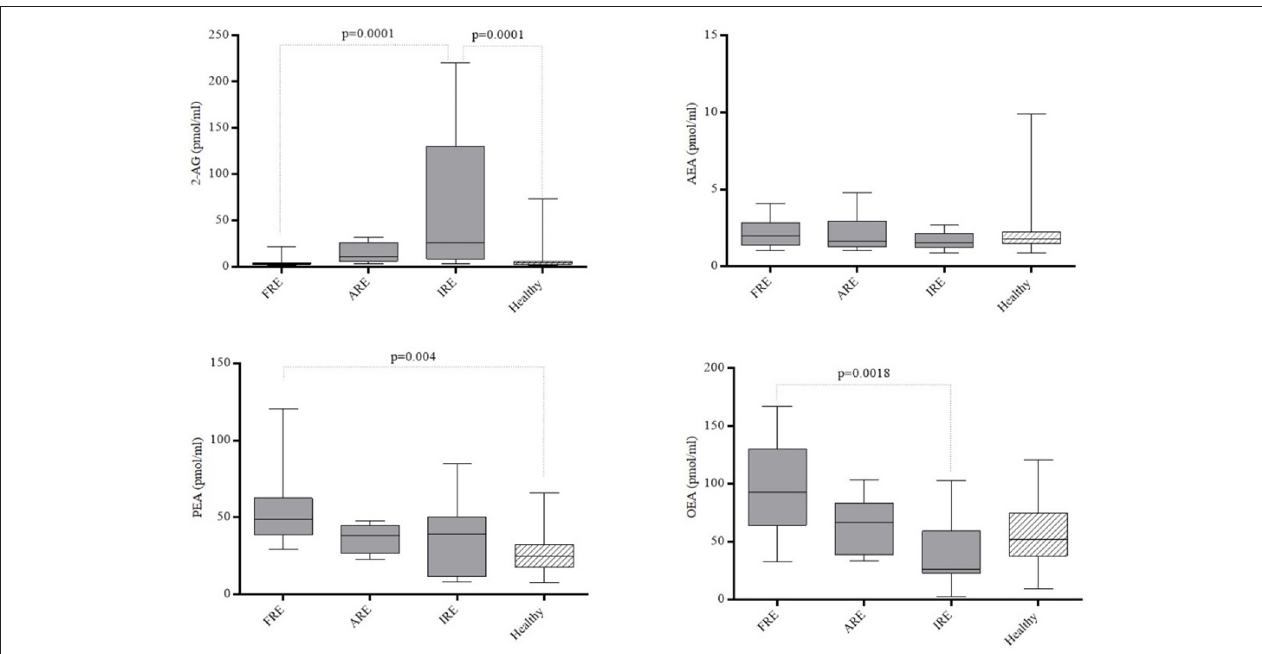
FIGURE 2 | Plasmatic concentrations of 2-arachidonoylglycerol (2-AG), N-arachidonoylethanolamine (AEA), N-palmitoylethanolamine (PEA) and N-oleoylethanolamine (OEA) in healthy dogs and in dogs affected by Food-responsive Enteropathy (FRE, n = 10), Antibiotic-responsive Enteropathy (ARE, n = 9) and Immunosuppressive-responsive enteropathy (IRE, n = 14). Boxes show interquartile ranges with median values represented by the central lines, and minimum and maximum values represented by the endpoints of vertical